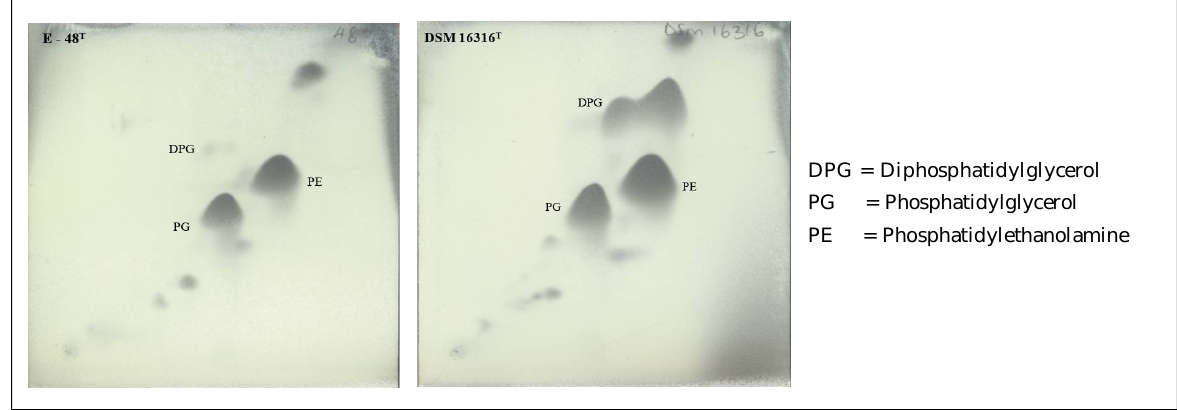
DPG = Diphosphatidylglycerol PG = Phosphatidylglycerol PE =